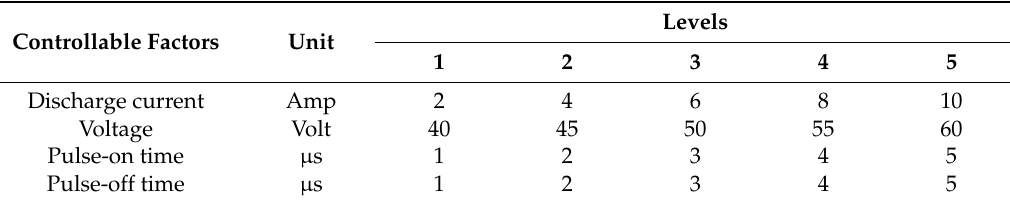
Table 1. WEDM process parameters and their levels.